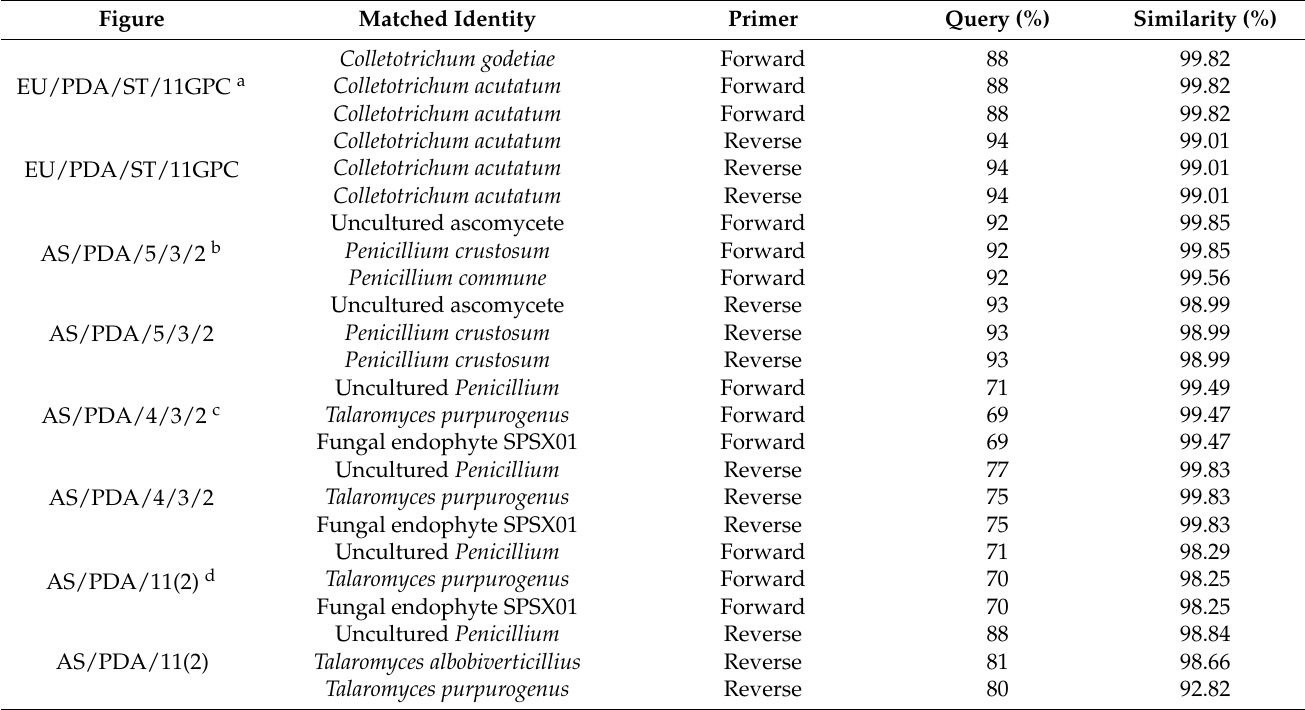
Table 1. Molecular identification of four endophytic fungal strains.